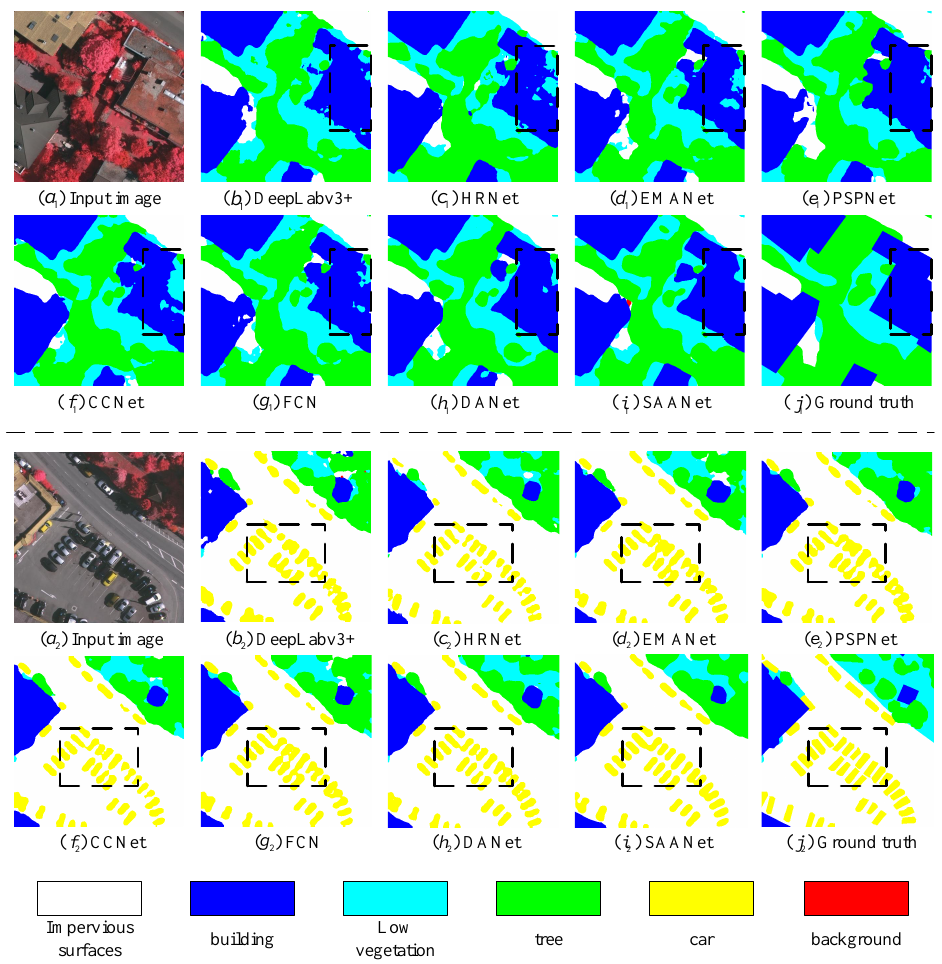
Figure 8. Visual results achieved by different networks on ISPRS Vaihingen dataset. For the first group, other methods incorrectly predict that several pixels representing buildings are low vegetation or tree class. For the second group, several pixels representing cars have rough edges. However, our SAANet can maintain category consistency and obtain more precise